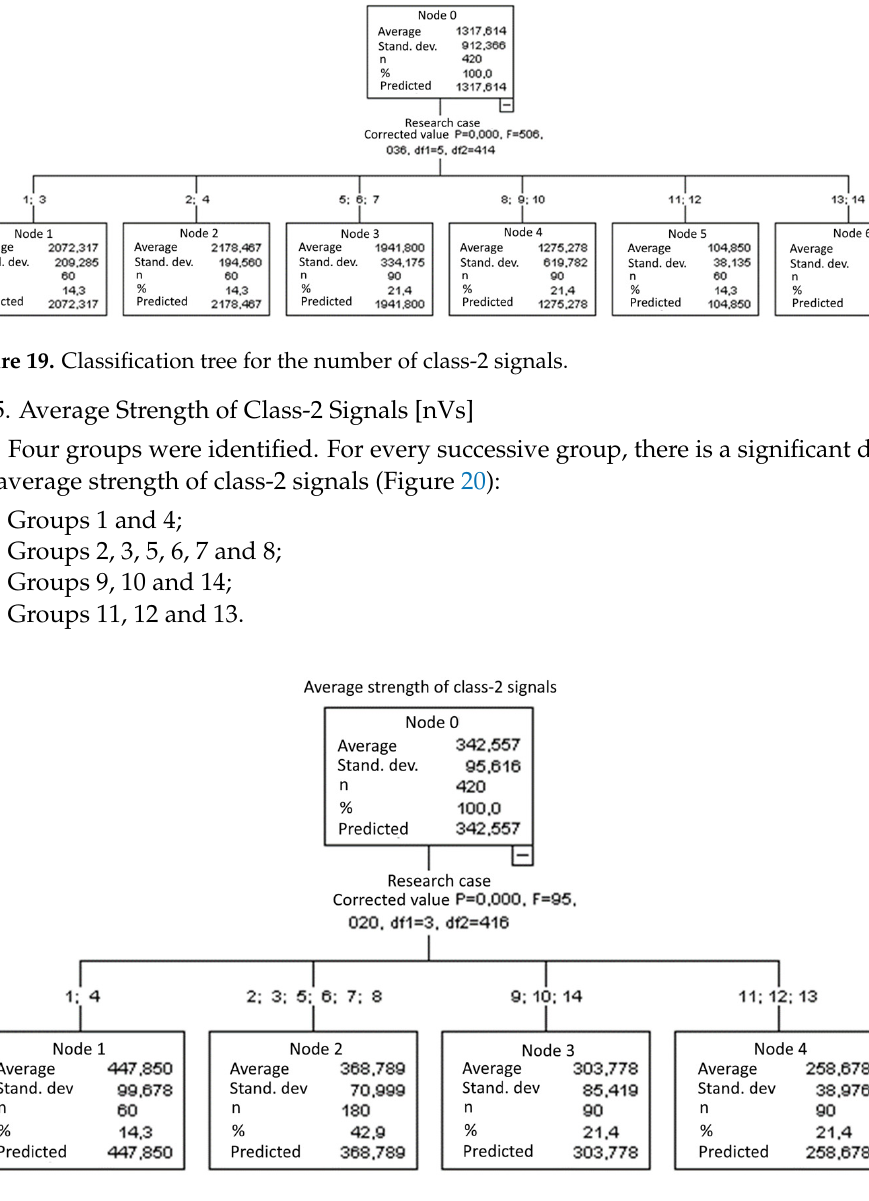
Figure 21. Classification tree for the average duration of class-2 signals.